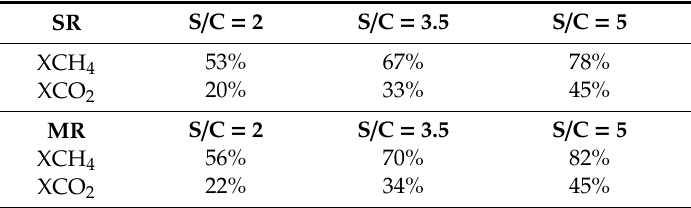
Table 7. E ff ect of S / C in SR and MR.